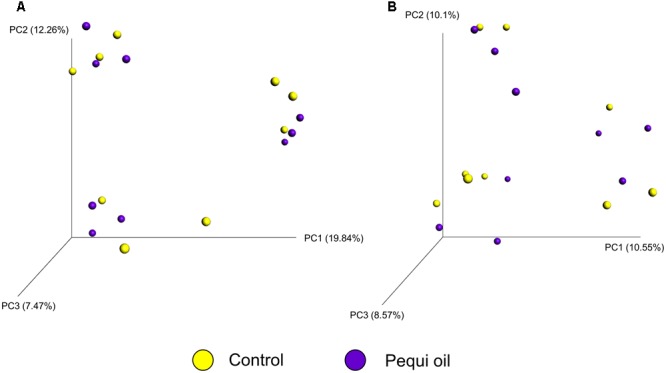
Principal coordinate analysis (PCoA) of the unweighted UniFrac distances for the effect of pequi oil supplementation on (A) LAM and (B) SAM samples. The percent variation explained by each principal coordinate is indicated on the axes. No rumen samples included. LAM, liquid-associated microbes; SAM, Solid-associated microbes.